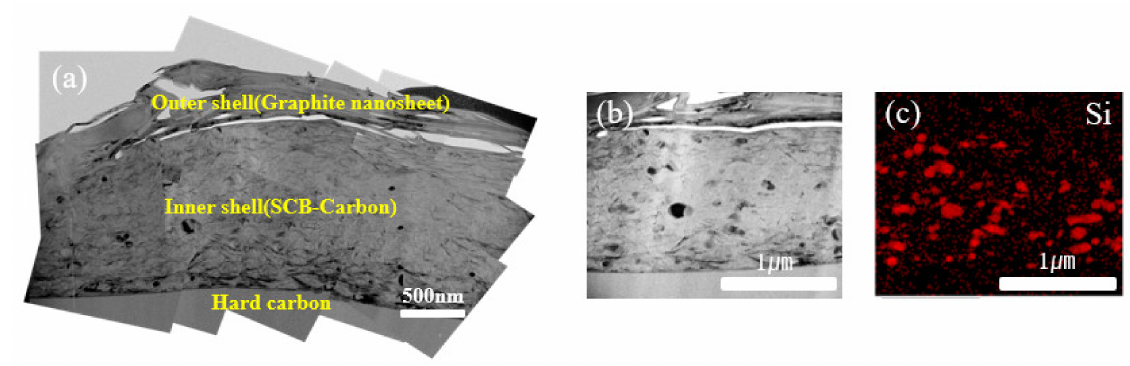
Figure 4. Cross-sectional TEM image of HSBGC sample ( a ), TEM image of shell region and corresponding elemental mapping of Si ( b , c